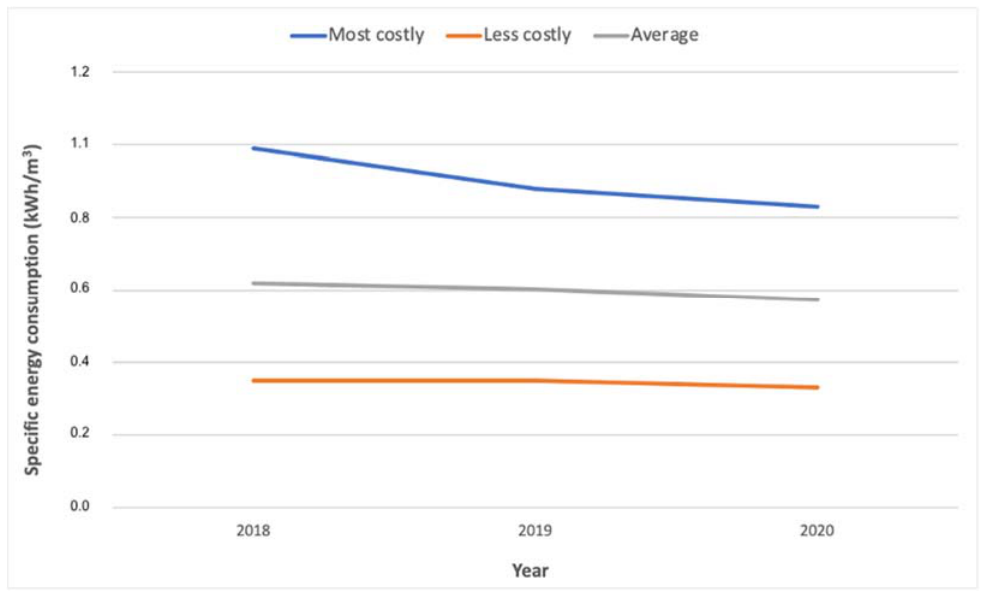
Figure 4. Evolution of the specific energy consumption, 2018–2020, for the 11 Portuguese wastewater management companies.